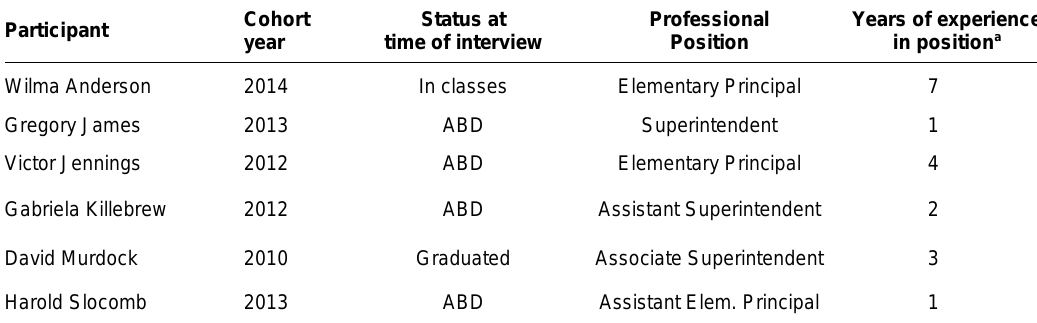
Table 1: Descriptive Data on Study Participants